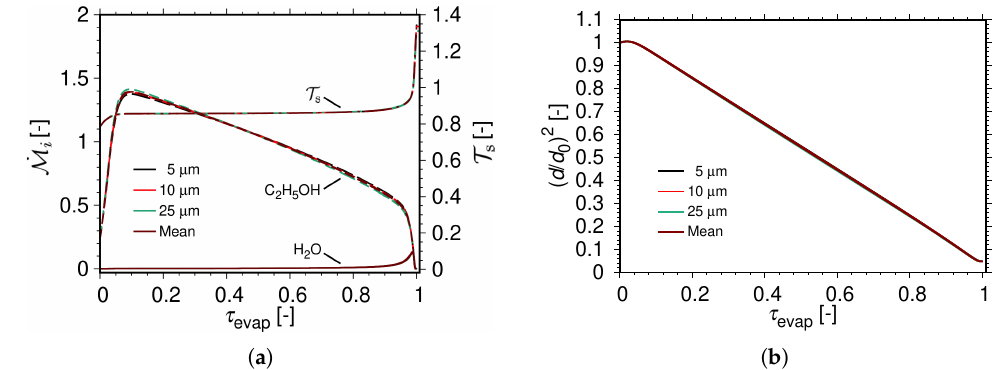
Figure 8. Normalized profiles with τ evap for different initial droplet sizes. T l,0 = 293.15 K, p = 1 bar, u 0 = 4 m/s and 8 m/s, T g,0 = 1200 K, Y C = 0.975, Y IN,0 = 0.025. ( a ) Dimensionless mass evapo- 2 H 5 OH,0 ration rate and dimensionless droplet surface temperature versus normalized droplet evaporation time. ( b ) Normalized droplet surface area versus normalized droplet vaporization time.